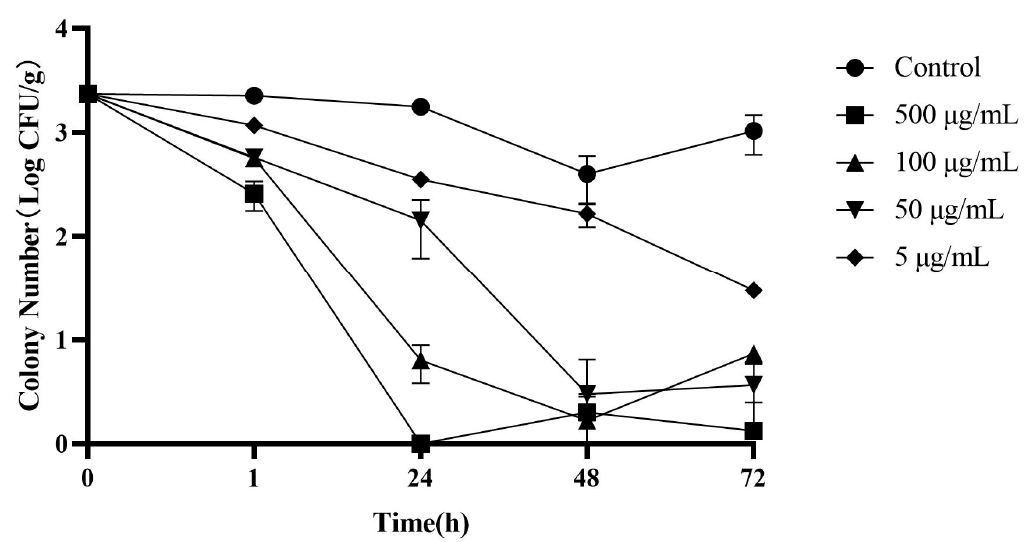
Figure 6. Inactivation of C. perfringens in duck meat by endolysin LysCP28 after incubation for 72 h at 4 °C. Changes of C. perfringens viable counts (log CFU/g) after treatment: 500 μ g/mL ( ), 100 μ g/mL ( ), 50 μ g/mL ( ), and 5 μ g/mL ( ) were recorded. Control samples of 10 3 CFU/g ( ). Values correspond to the mean for three independent experiments.